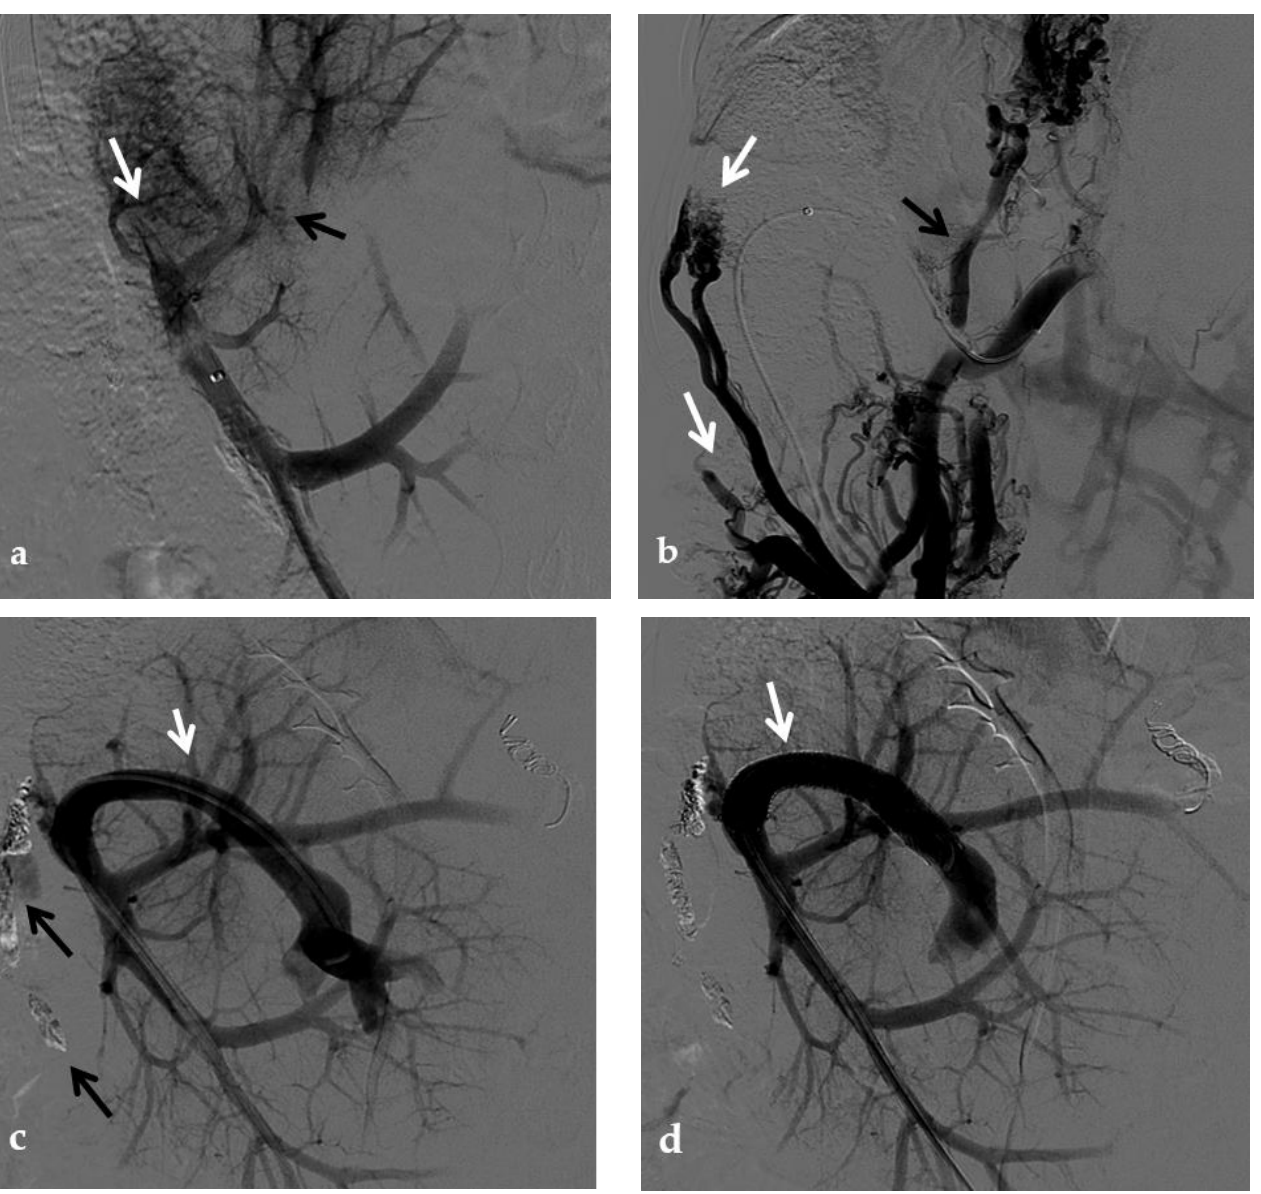
18 of 32 Figure 9. Anteroposterior view of a percutaneous transhepatic portography imaging series per- formed for chronic complete portal vein thrombosis with cavernous transformation in an 11-year- old boy with a history of gastrointestinal bleeding and portal hypertension 10 years after deceased- donor orthotopic liver transplantation (split II – III) for biliary atresia. ( a ) Portography image shows a regular representation of the segment 3 portal branch, while the segment 2 portal branch has a peripheral defect of opacification due to flow reversal, resulting from portal cavernoma and extra- hepatic capsular feeding from gastric vessels (black arrow). Complete occlusion of the extrahepatic